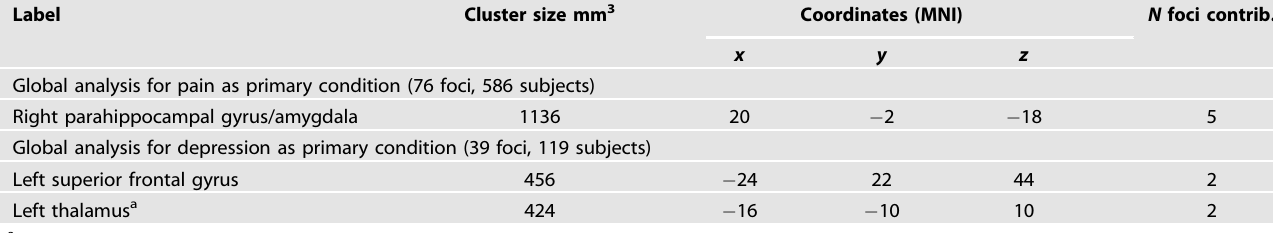
Table 3. Signi fi cant clusters and within-cluster peaks identi fi ed in global ALE analyses of both pain and depression as primary condition, presented separately for the original sample of 68